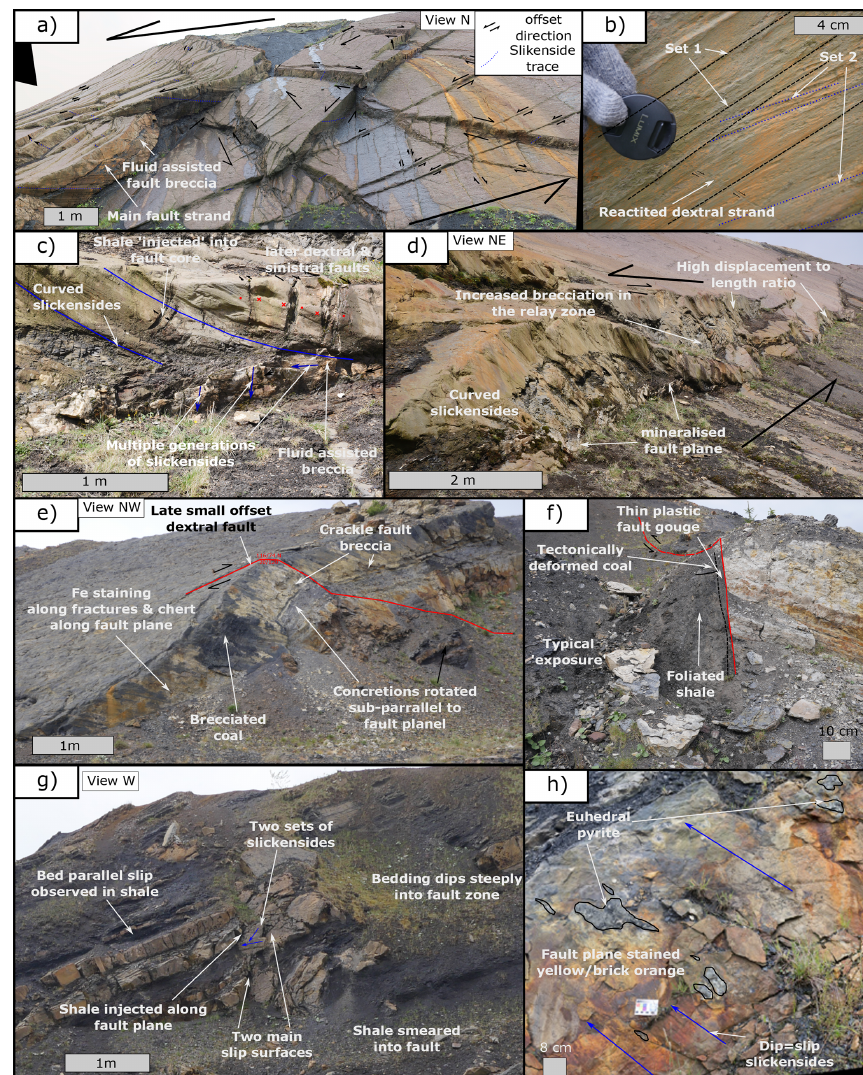
Figure 6. Characteristics of faults that cut multiple lithologies. (a) Complex fault mesh (following Sibson, 1996) consisting of multiple strands of sinistral and dextral strike–slip fault planes (stratigraphic separation marked with arrows) picked out by shallow striations and the offset of the McDonald Limestone bedding plane. (b) Field photograph of a ∼ 3m stratigraphic separation fault strand within the complex fault mesh (a) that displays multiple generations of fault striations, with local dextral reactivation separating striations belonging to set 2. (c) Fault architecture and (d) view along a ∼ 50m strike length of a highly segmented fault zone, displaying 3 to 5m stratigraphic separation exposed along the southerly dipping bedding dip-slope. Fault architecture of the same 5m stratigraphic separation fault-cutting (e) lithologies surrounding the McDonald Seat Earth and (g) interbedded sandstones, siltstones, and shales of the Lower Limestone Coal Formation. (f) Primary slip plane of the ∼ 80m stratigraphic separation fault that cuts the west of the site; (h) Shallowly dipping, sinistral dip-slip fault plane within a ∼ 2m thick sandstone bed of the Limestone Coal